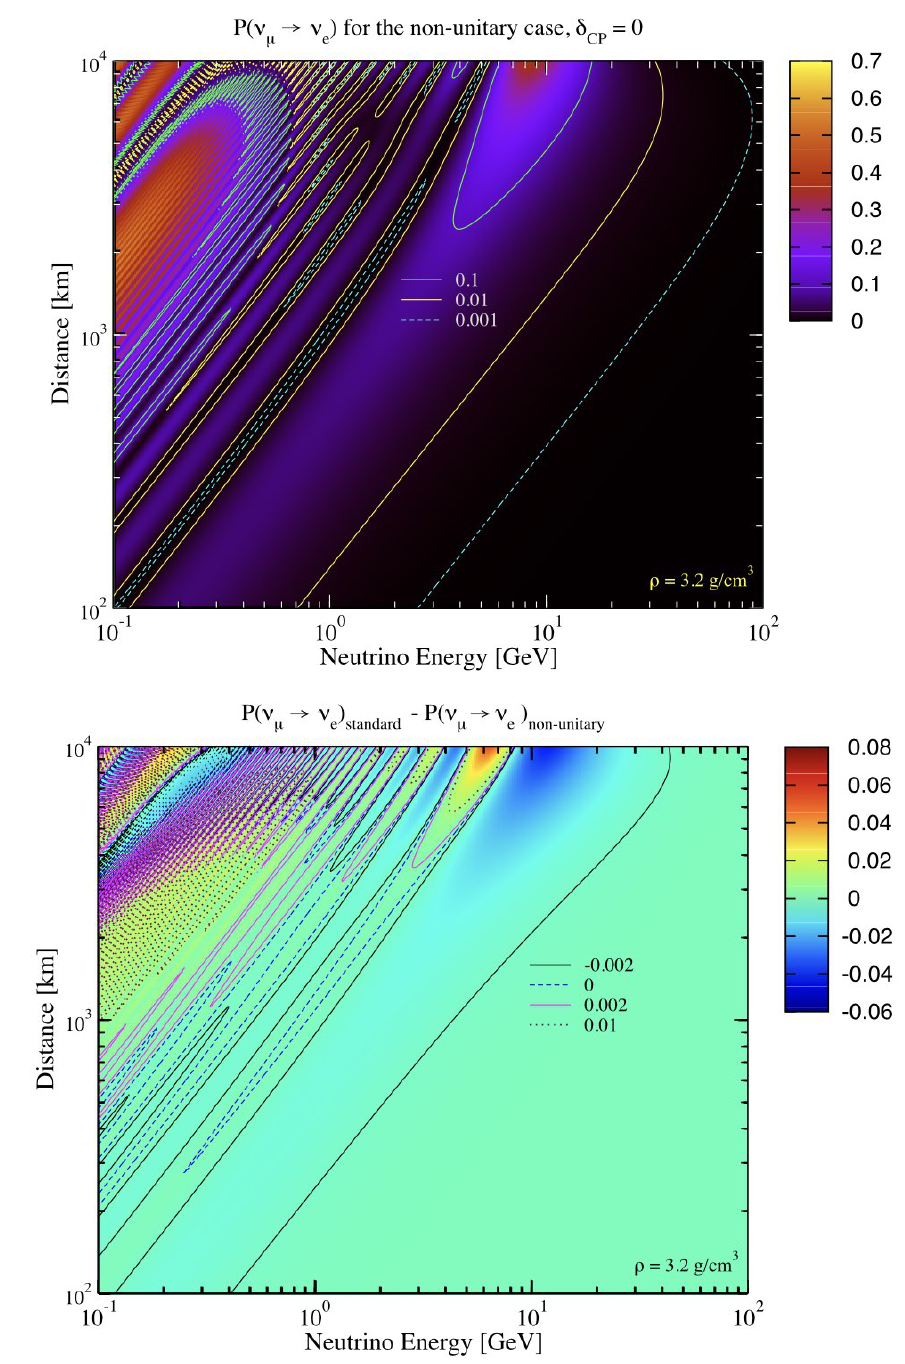
Figure 1 . In the upper panel (a), presented is the iso-contour of P ( (cid:23) (cid:22) ! (cid:23) e ) (0) spanned by neutrino energy E and baseline L . In the lower panel (b), the iso-contour of the di(cid:11)erence (cid:1) P ( (cid:23) (cid:22) ! (cid:23) e ) (cid:17) P ( (cid:23) (cid:22) ! (cid:23) e ) standard (cid:0) P ( (cid:23) (cid:22) ! (cid:23) e ) (0) of unitarity-violating as well as the standard mixing parameters taken, see the text.